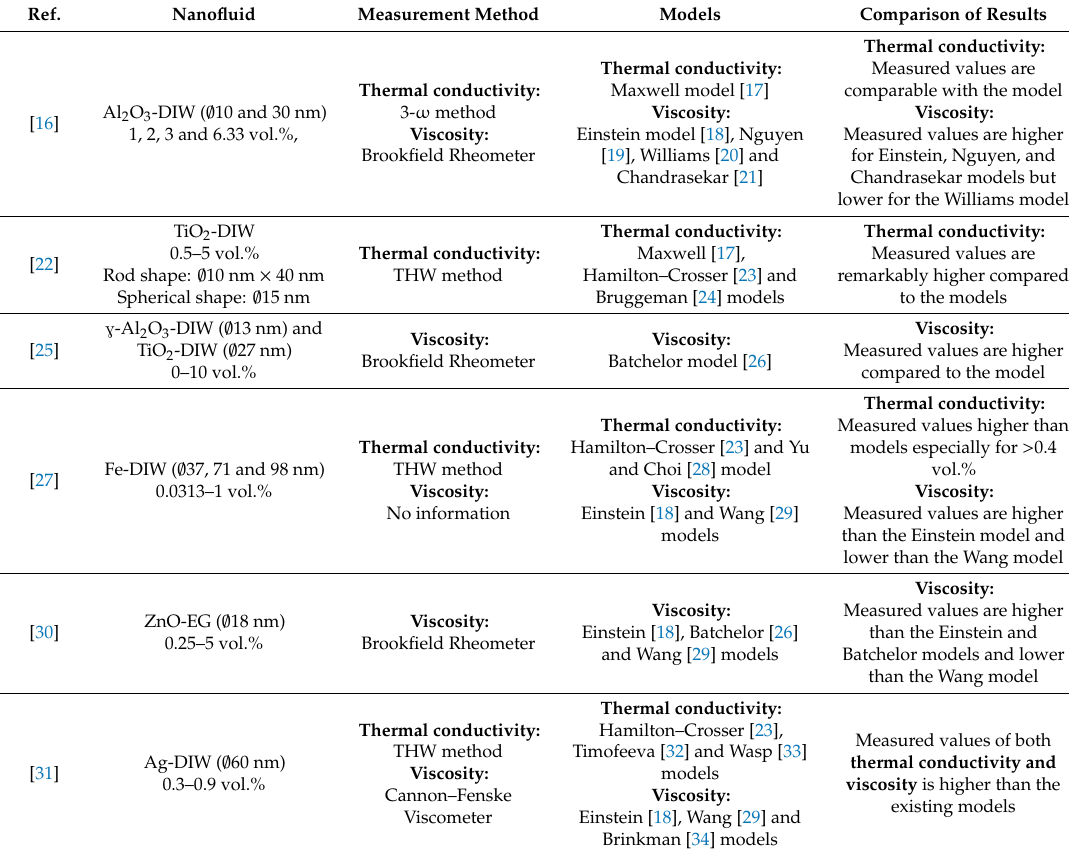
Table 1. Comparison of nanofluids’ thermophysical properties obtained from predictions and measurements for selected